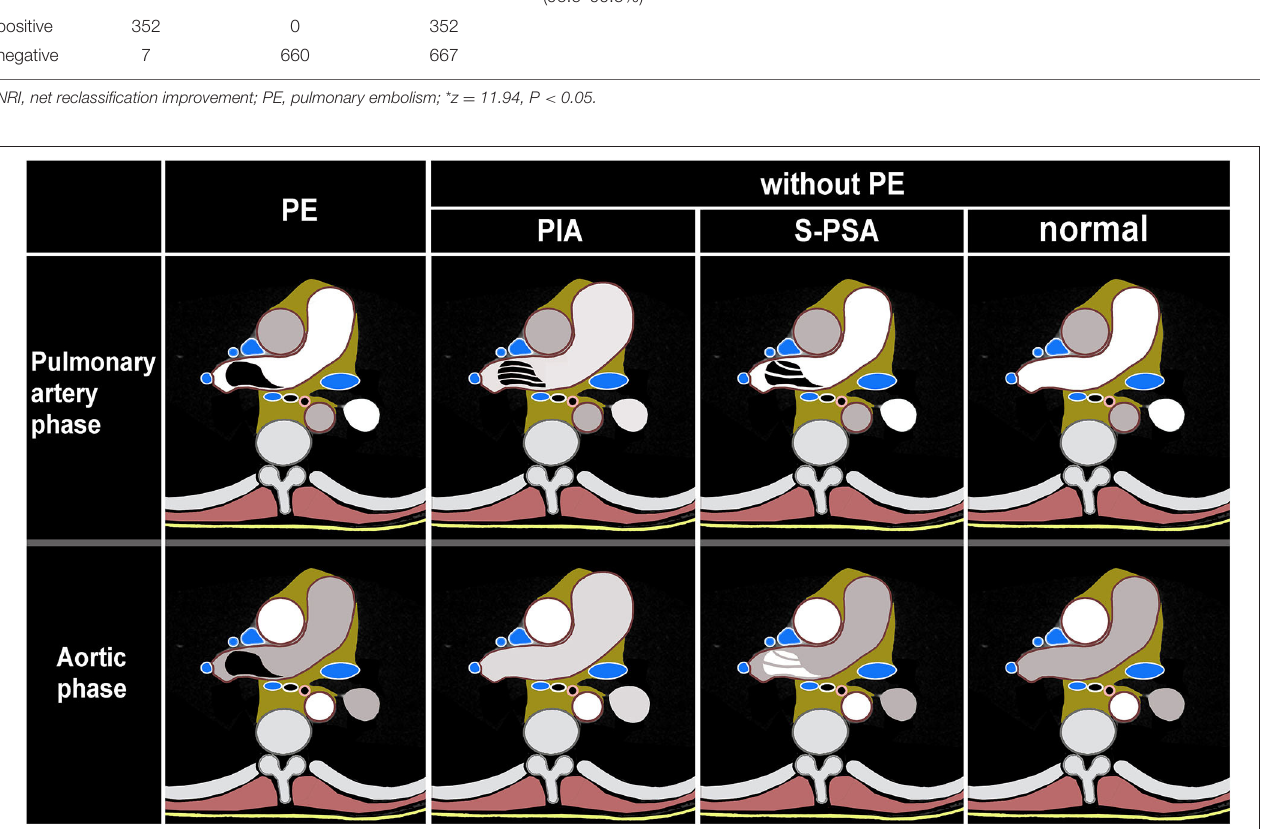
FIGURE 2 | Schematic illustration of dual phase computed tomography pulmonary angiogram (DP-CTPA) diagnosis. PE (pulmonary embolism, Supplementary Video 1 ) lesion shows low density in pulmonary artery phase and aortic phase. PIA (pulmonary insufficiency artifacts, Supplementary Video 2 ): The diameter of the main pulmonary artery and the left and right pulmonary arteries increases. During the pulmonary artery phase, the pulmonary arteries exhibit filling defects. During the aortic phase, there is still more contrast media filling in the pulmonary arteries and the filling defect in the pulmonary arteries disappears in the aortic phase. S-PSA (systemic-pulmonary shunt artifacts Supplementary Video 3 ): In pulmonary artery phase, there is a filling defect or no development of the lumen in the pulmonary artery or its branch. The filling defect or no development of the lumen presents as a high density in the aortic phase.